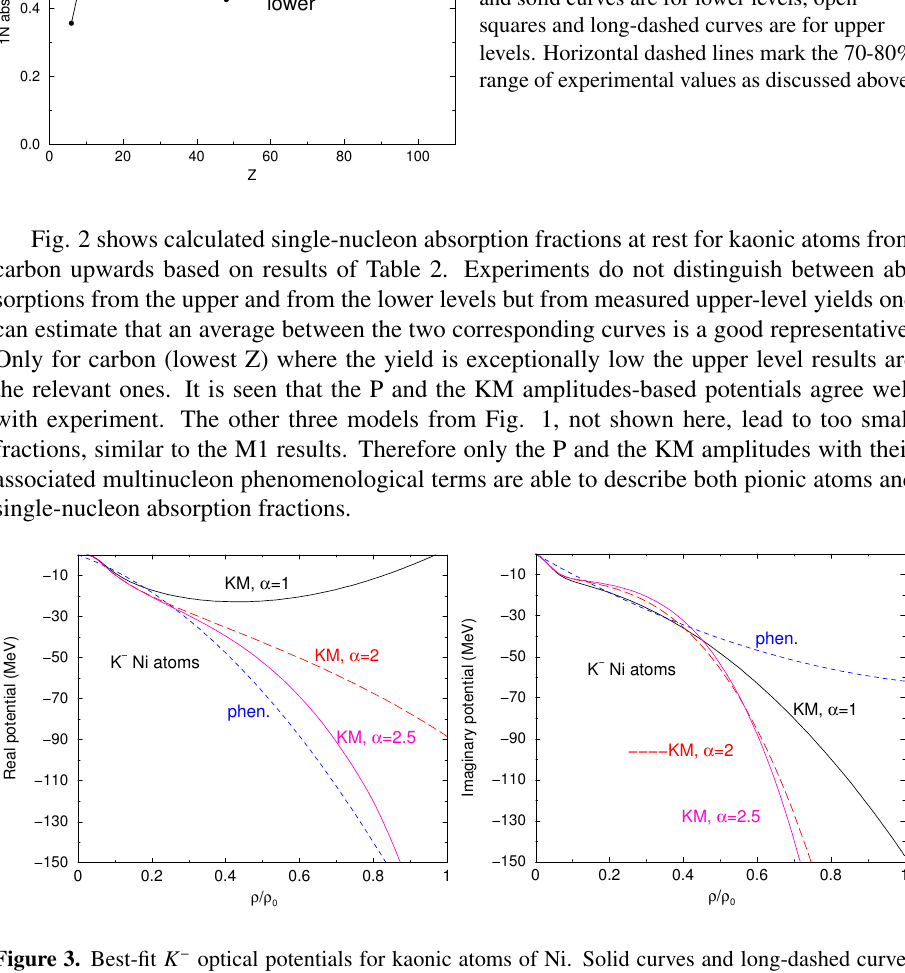
Figure 2. Calculated fractions of single-nucleon absorption for amplitudes M1, P, KM and YA augmented by the respective phenomenological term from Table 2. The P and KM results are indistinguishable on this figure. Solid circles and solid curves are for lower levels, open squares and long-dashed curves are for upper levels. Horizontal dashed lines mark the 70-80% range of experimental values as discussed above.